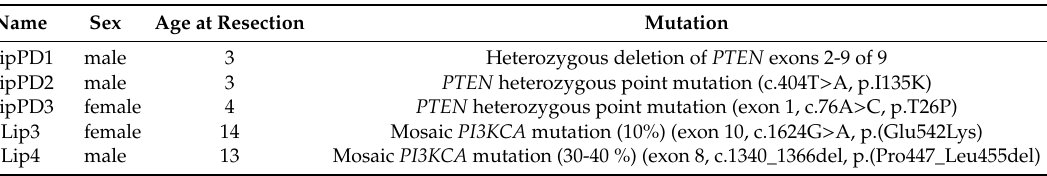
Table 1. Lipoma cells from pediatric PHTS and PROS patients